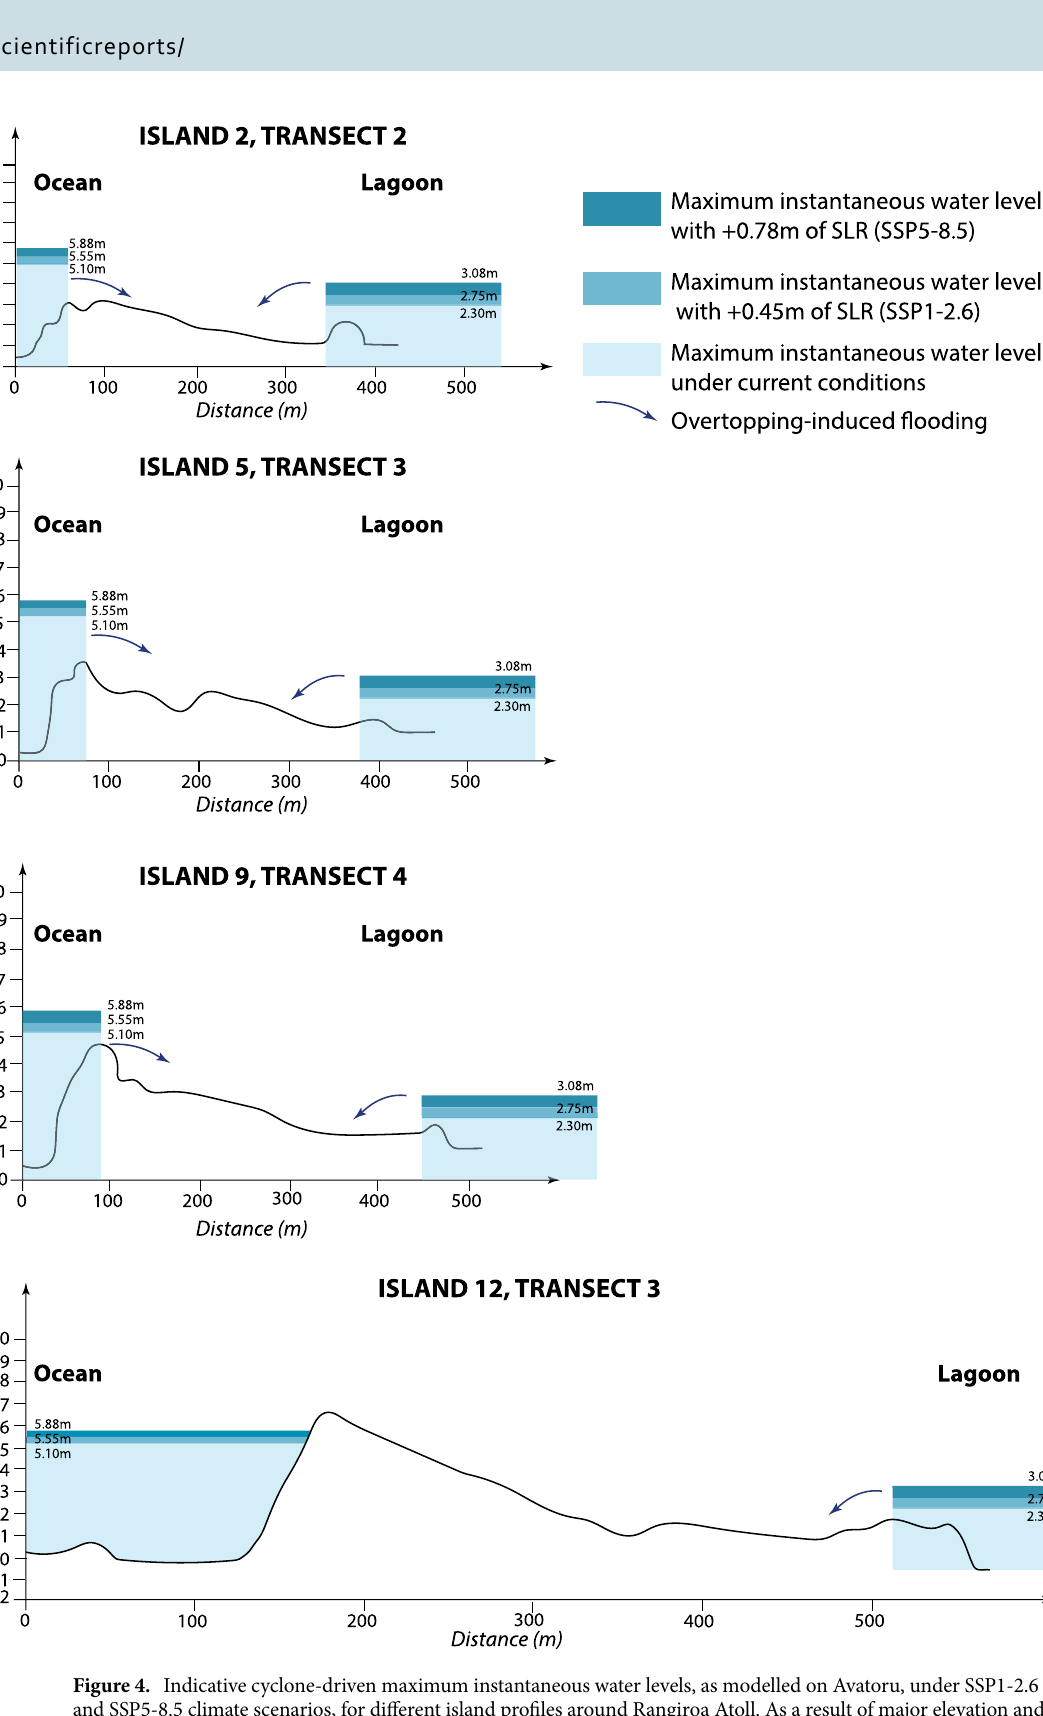
Figure 4. Indicative cyclone-driven maximum instantaneous water levels, as modelled on Avatoru, under SSP1-2.6 and SSP5-8.5 climate scenarios, for different island profiles around Rangiroa Atoll. As a result of major elevation and topography differences, islands Nos. 2, 5, 9 and 12 are unequally susceptible to extreme cyclone-driven overtopping under both SSP1-2.6 and SSP5-8.5: whereas islands Nos. 2, 5 and 9 are flooded over their entire surface, island No. 12 has non flooded areas along its elevated ocean side. Note that extreme water levels are based on simulations made for Avatoru (No. 2), and that the estimation of flooding on island No. 12 would require a detailed hydrodynamic study. Yet, values provided in ref. 52 are considered conservative enough to support the conclusion that island No. 12 offers the best safety potential during a TC. For details on Extreme Sea Levels, see Fig. 7 in “Materials and